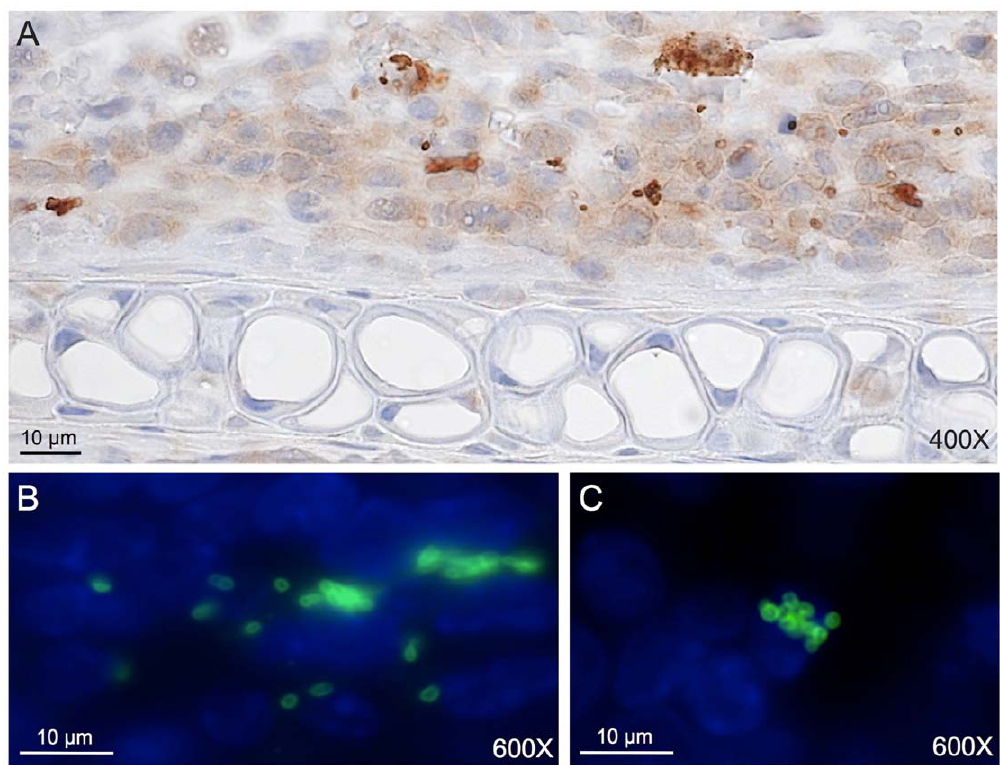
Figure 6. Detection of O.tsutsugamushi at the injection site (Panels A and B) and draining lymph node (Panel C) at 7 days post inoculation. In panel ‘‘A’’ O. tsutsugamushi in a mouse ear is demonstrated using peroxidase DAB reaction as brown colored dots (counterstain hematoxylin, original magnification x400). The immunofluorescence staining of O. tsutsugamushi is shown in panels ‘‘B’’ (mouse ear) and ‘‘C’’ (draining lymph node): O. tsutsugamushi with FITC (green) and DAPI nuclear counterstain in blue (original magnification